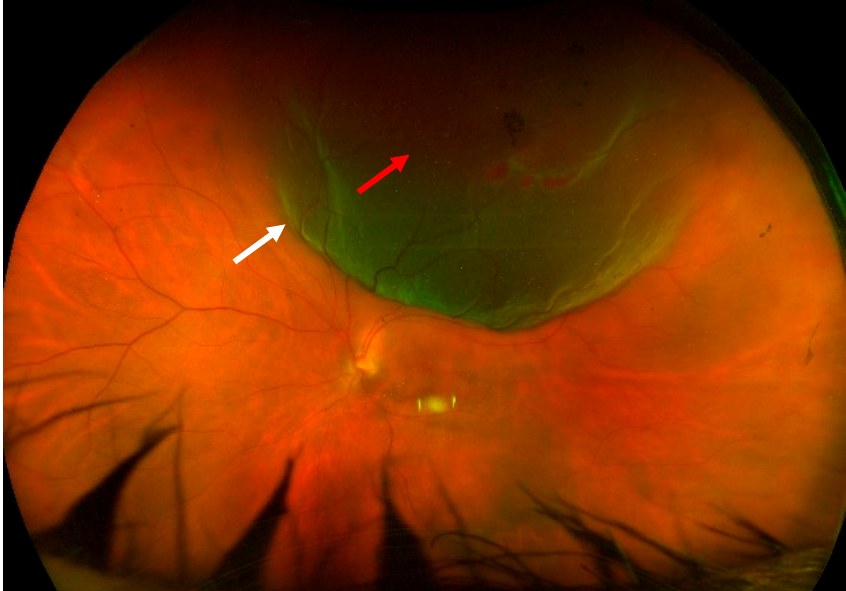
Figure 1. Pre-operative fundus picture. Left eye, superior RRD (white arrow) with a large retinal break at 12–1 o’clock (red arrow).